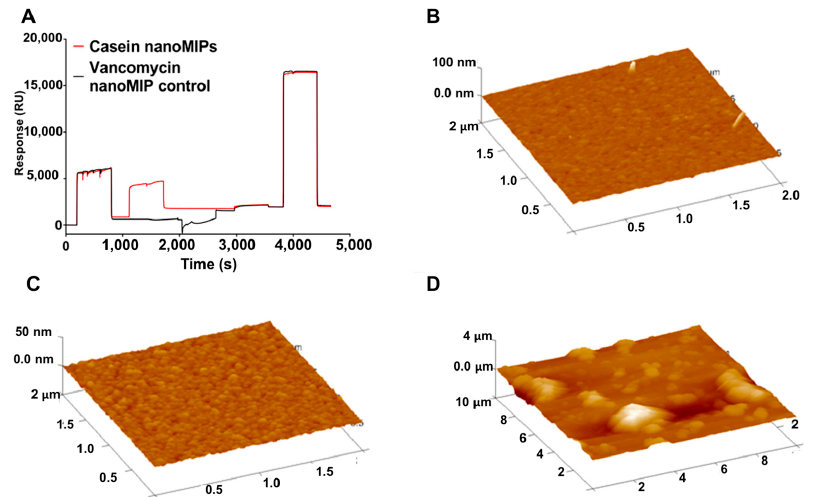
Figure 5. ( A ) SPR sensorgram; AFM image of ( B ) bare gold, ( C ) SAM monolayer, and ( D ) covalently attached nanoMIPs. Reprinted from [78] with permission from Ashley et al. attached nanoMIPs. Reprinted from [78] with permission from Ashley et